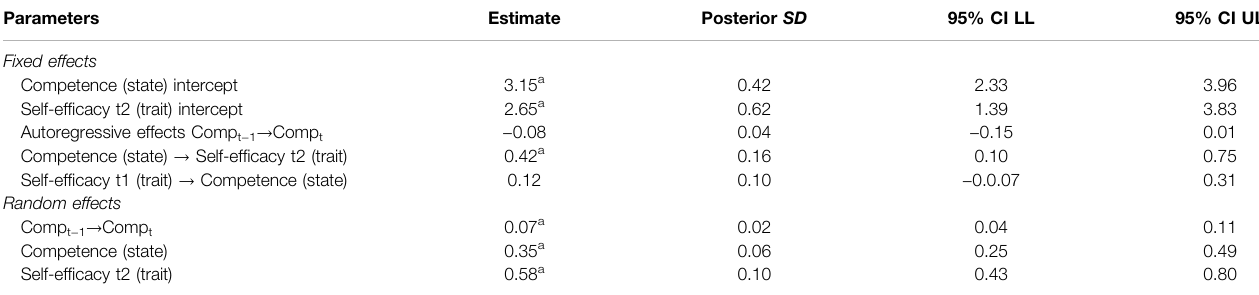
TABLE 1| Unstandardizedparameterestimatesfor themultilevel autoregressivemodel explainingtheeffectsoffeelings ofcompetence (state)onpre-serviceteachers ’ self- ef fi cacy for conducting biology experiments (trait variable on the between level).